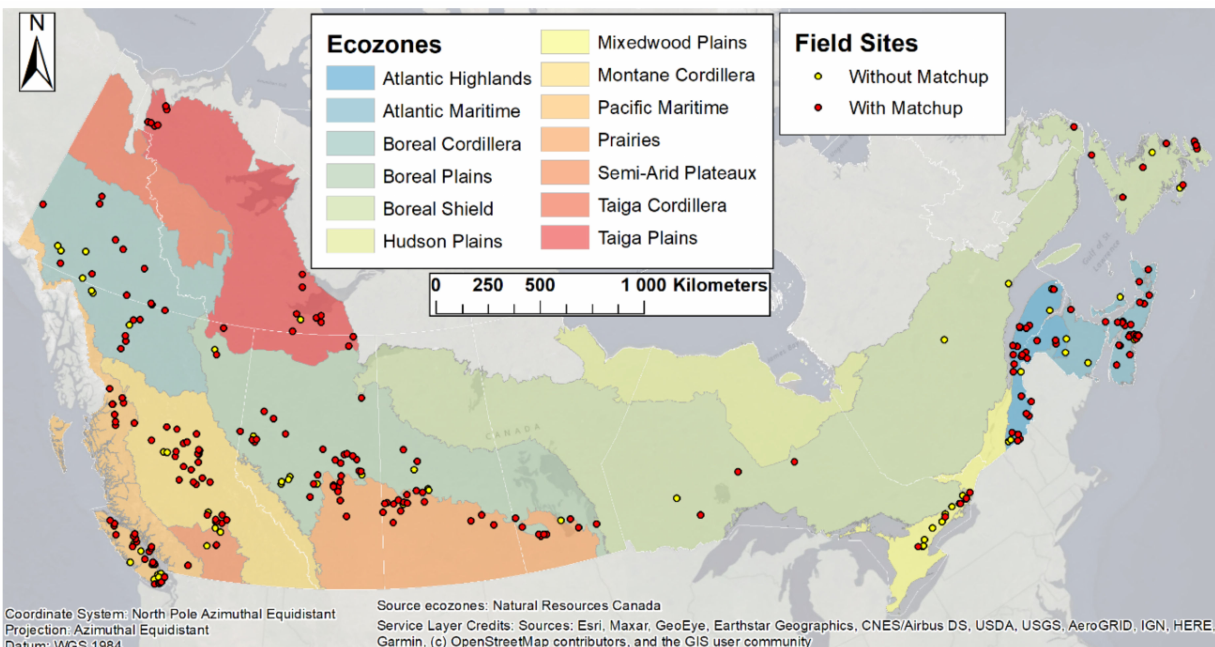
Figure 1. The ecozones of Canada and sampling stations (dots) with spectra that passed the quality control procedure from the LakePulse fieldwork of 2017, 2018, and 2019. Red dots are lakes with a matchup with either L8 or S2 satellite